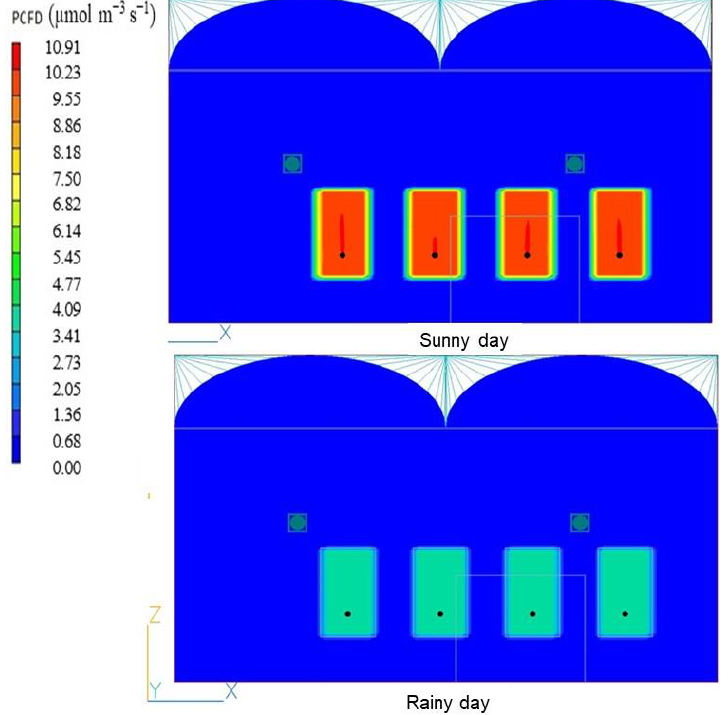
Figure 14. Net photosynthetic (PCFD) inside the greenhouse: 1000 ppm of CO 2 enrichment cases on sunny and rainy day. sunny and rainy